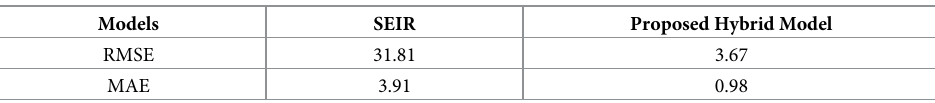
Table 3. RMSE value of